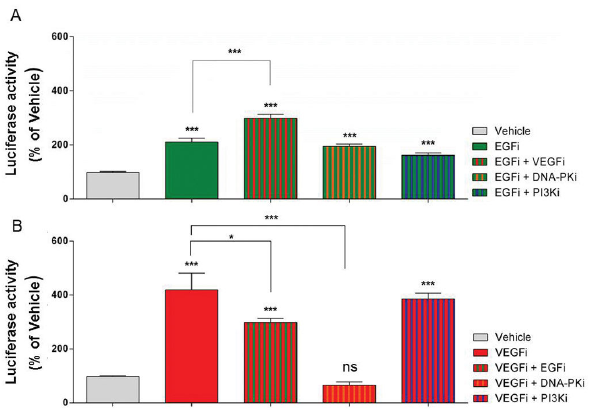
Figure 2. Modulation of Lmx1a reporter gene expression by combinations of small molecule kinase inhibitors. Luciferase activity was assayed on day 8 after exposure of differentiating mESCs to combinations of SMAs from day 4-8. (A) Activity of EGF inhibitor plus other SMAs (B) Activity of VEGF inhibitor plus other SMAs, ***p<0.001 and *p<0.05, one-way ANOVA using Bonferroni’s multiple comparison test. Data expressed as mean ± SEM, n=4. luciferase expression whereas PTEN inhibition in combination with either inhibition of Akt, or DNA-PK signaling, were able to significantly (p<0.05) promote luciferase activity by day 8 (Figure 3A ). In contrast, incubation with MAPK kinase (MEK1 and MEK2) inhibitors and the PLC-γ inhibitor (U-73122) caused a significant (p<0.05) decrease in reporter activity (Figure 3A ).